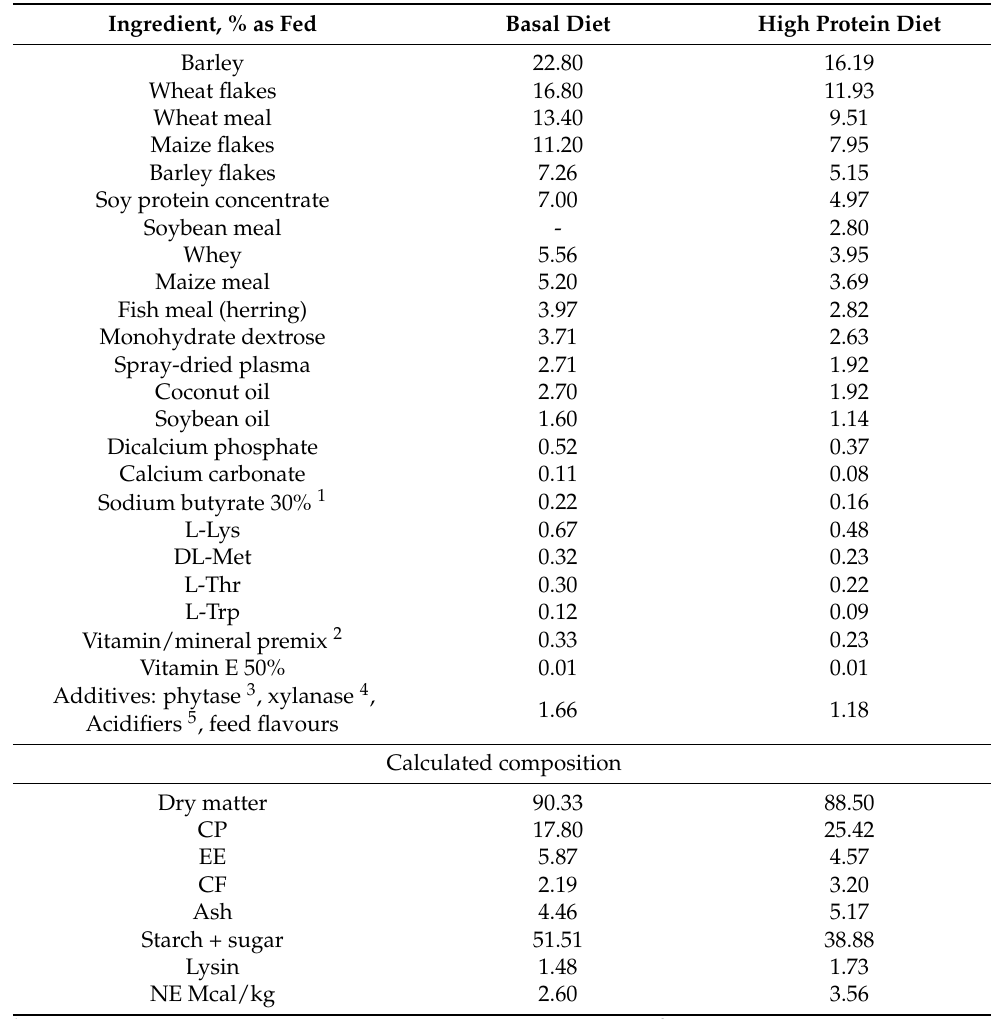
Table 8. Composition of experimental